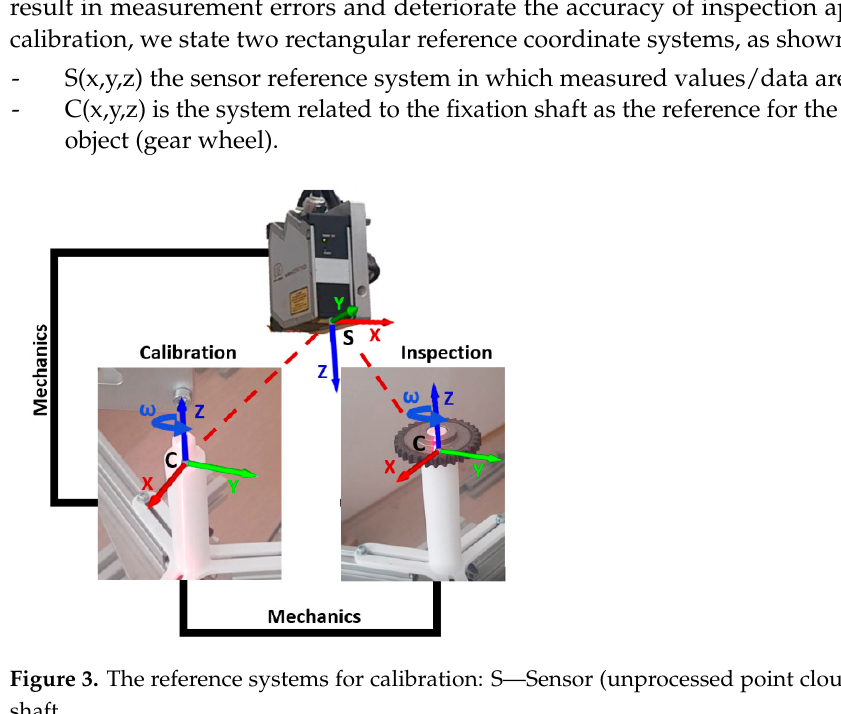
Figure 2. The experimental inspection laboratory stand; first step ( left ): scanning the shaft as a calibration process; second step ( right ): scanning the gear wheel.